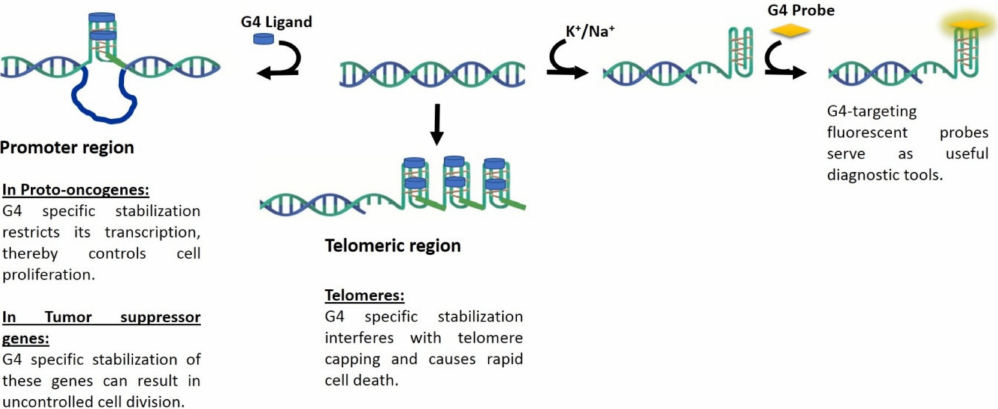
Figure 2. Schematic representing action of G4-stabilizing ligands and G4-targeting fluorescent